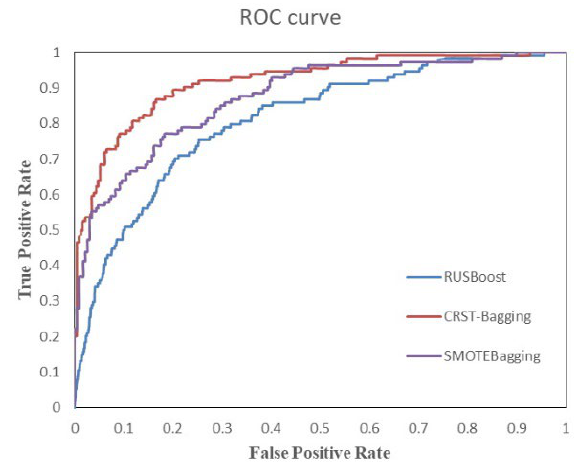
Figure 8. ROC graph of RUSBoost, SMOTEBagging, CRST-Bagging on the test set.